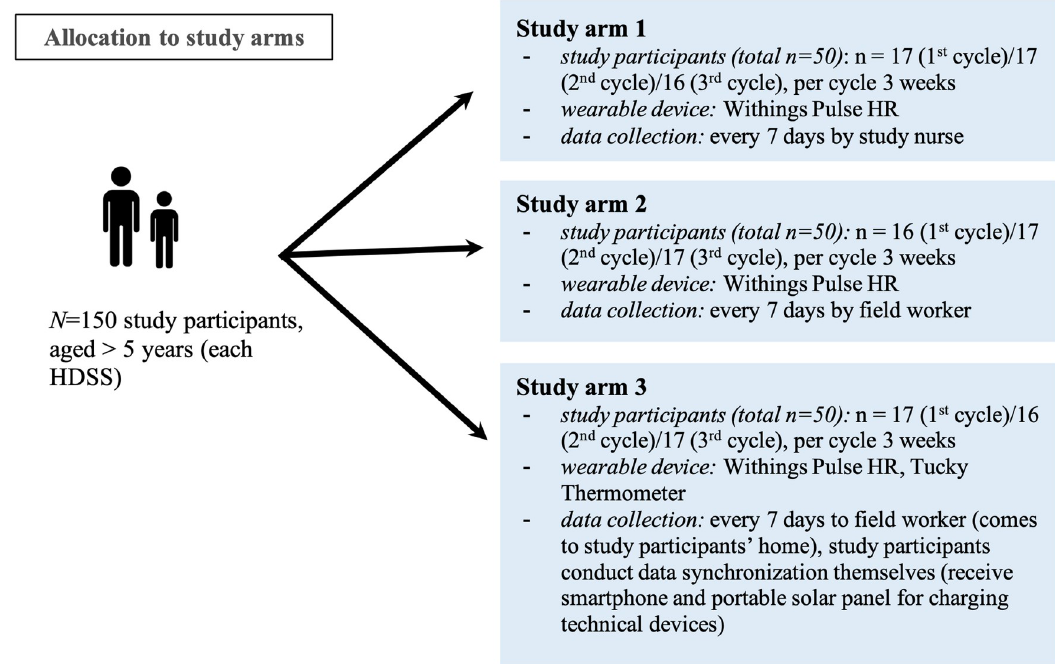
Fig 2. Three study arms in detail. Allocation of study participants to different study